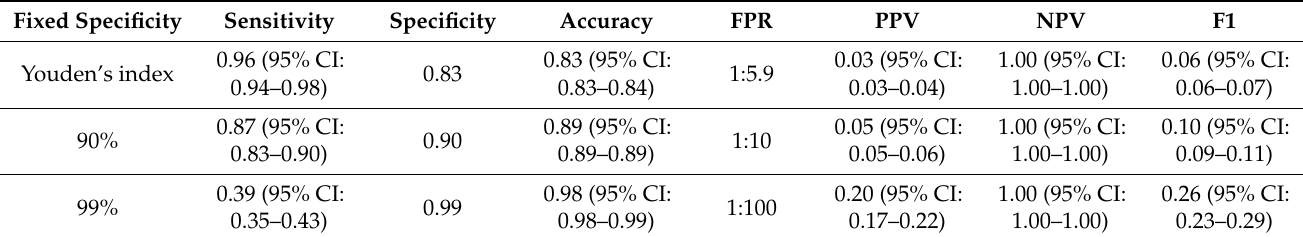
Table 5. Metrics of the logistic regression-tf-idf–gradient boosting ensemble model for predicting overall in-hospital mortality.